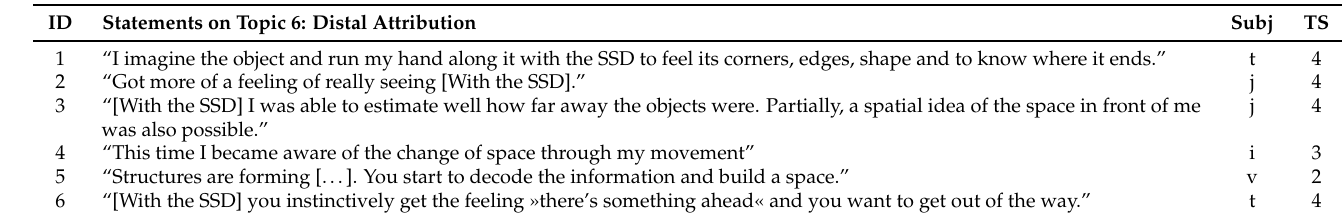
Table A8. Abbreviations used in this table: ID = statement identifier; Subj = subjects; TS = Trial